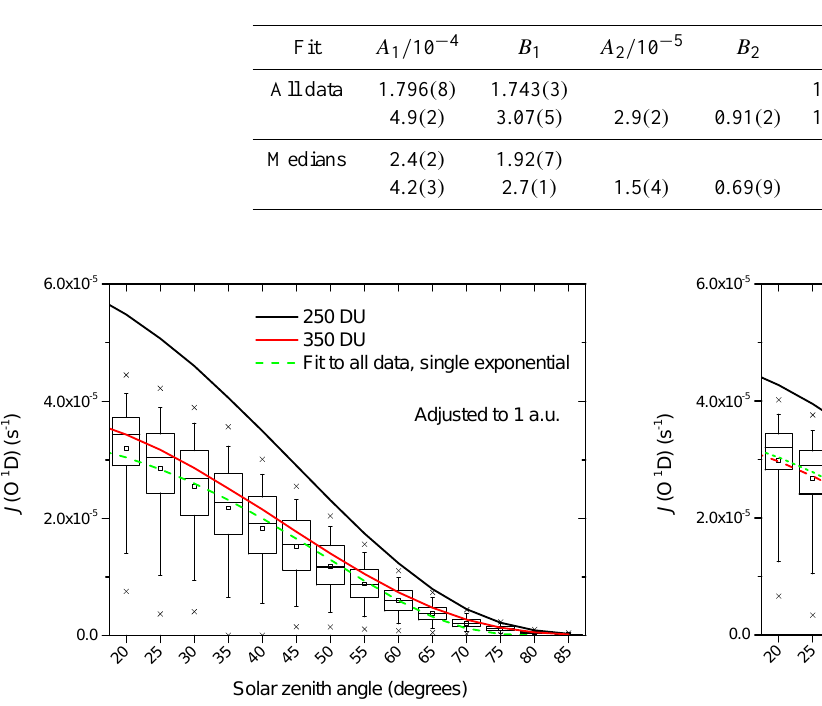
Table 2. Results for fitting J (O 1 D) with the form shown in Eq. (7). Brackets [...] surround values that have been assumed in the fit. Uncertainties (in brackets) are standard errors in the last quoted figure of the fitted parameters. Units for A 1 and A 2 are s − 1 . The “median fit” is a fit to the medians as shown in Fig. 5.